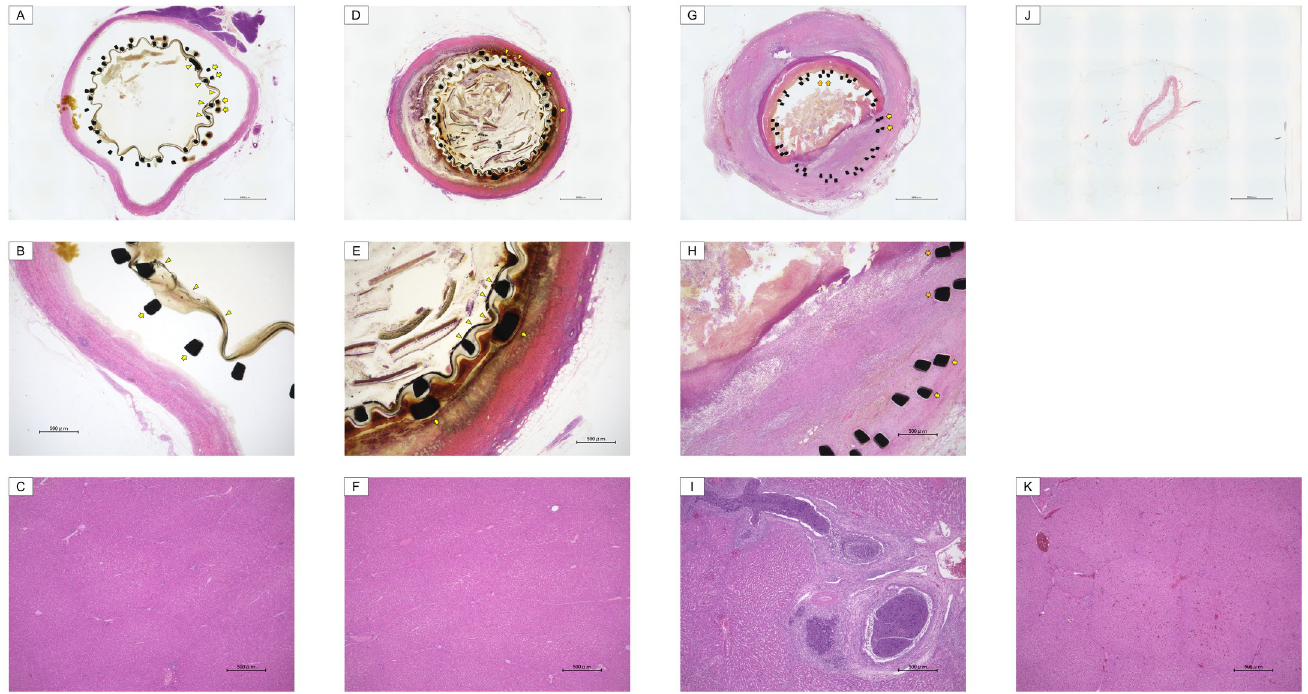
Fig 3. Pathological findings at 6-month follow-up in the PMEA and control groups. A–C (PMEA): Infiltration of small round cells, such as lymphocytes and plasma cells, bleeding, granulation tissue proliferation, foreign body giant cells, proliferation of mucosal epithelial cells of the bile duct and submucosal muscles, and fibrosis were not observed in the bile duct (A, B: Cole’s hematoxylin–eosin staining) and liver (C: Hematoxylin–eosin staining). The yellow arrowhead indicates the stent strut and cover membrane of the PMEA-CSEMS; and the yellow arrow indicates the stent strut of the short USEMS for migration. D–F (conventional CSEMS): Infiltration of small round cells, such as lymphocytes and plasma cells, bleeding, granulation tissue proliferation, foreign body giant cells, proliferation of mucosal epithelial cells of the bile duct and submucosal muscles, and fibrosis were not observed in the bile duct (D, E: Cole’s hematoxylin–eosin staining) and liver (F: Hematoxylin–eosin staining). The yellow arrowhead indicates the stent strut and cover membrane of the conventional CSEMS; and the yellow arrow, the stent strut of the short USEMS for migration. G–I (USEMS): The stent strut was buried in the thickened fibrous wall, and many small round cells were observed in the wall (G, H: Cole’s hematoxylin–eosin staining). An embolized bacterial mass was observed in the dilated intrahepatic bile duct. Kupffer cells and granulomas were observed in the liver parenchyma. Infiltration of inflammatory cells, fibrosis, and hyperplasia of the bile ducts were observed between the hepatic lobules at 20 days in the USEMS group (I: Hematoxylin–eosin staining). The orange arrow indicates the stent strut of the USEMS; and the yellow arrow, the stent strut of the short USEMS for migration. J–L (without ERCP): Inflammatory cell infiltration and fibrosis were not observed in the bile duct (J: Cole’s hematoxylin–eosin staining) and liver (K: Hematoxylin–eosin